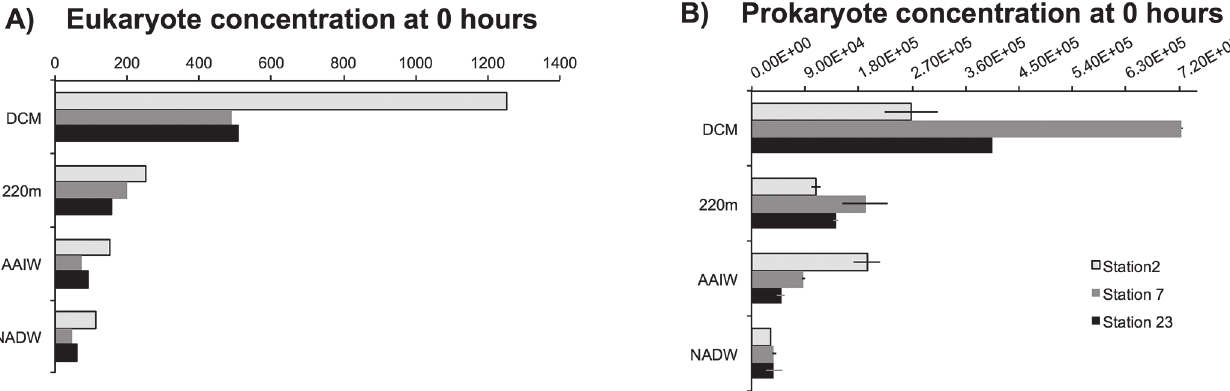
Fig 3. Fig 3A: Eukaryote concentrations (#Euks ml -1 ) at 0 hours obtained through DAPI stained counts at stations 2, 7 and 23. Fig 3B: Prokaryote concentrations (# bacteria (cid:1) mL -1 ) obtained through DAPI stained counts at stations 2, 7 and 23. Error bars represent the standard deviation of the mean (n =